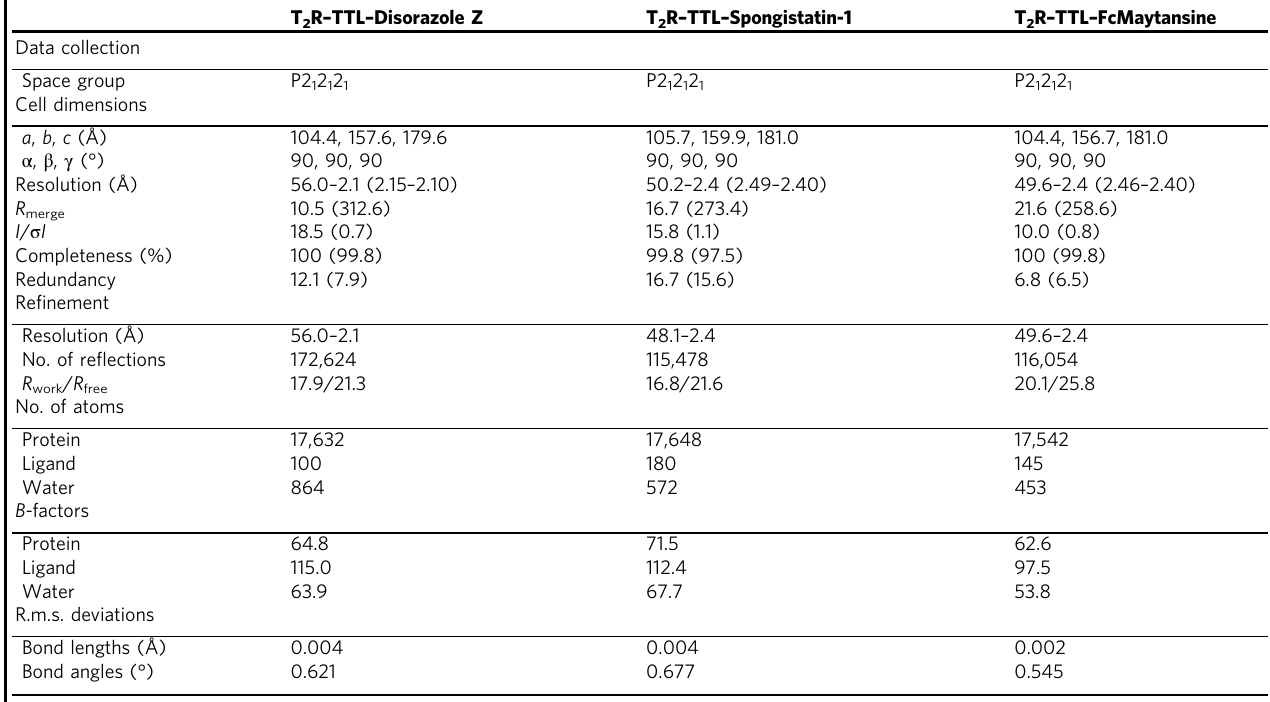
Table 1 Data collection and re fi nement